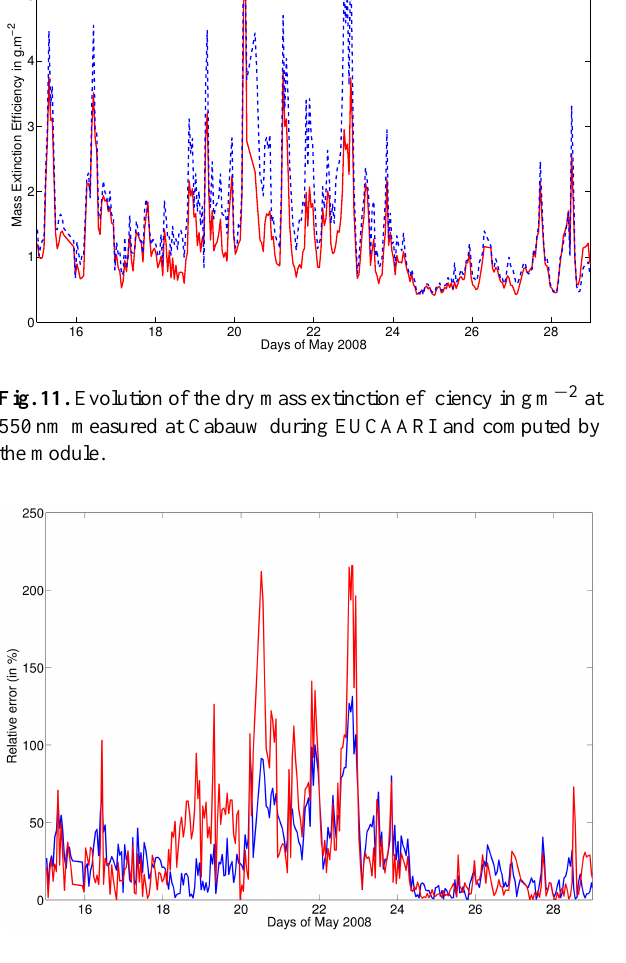
Fig. 12. Relative error between the mass concentration measured by the AMS + MAAP and that deduced from the SMPS+APS for particles up to 500nm (blue line) and difference between mass ex- tinction efficiency observed and computed (red